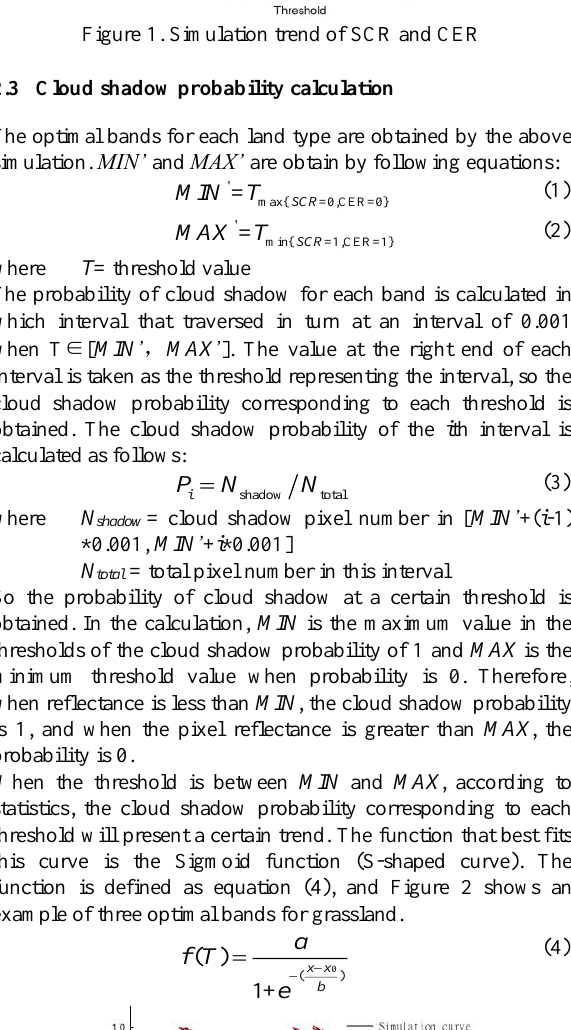
Figure 1. Simulation trend of SCR and CER